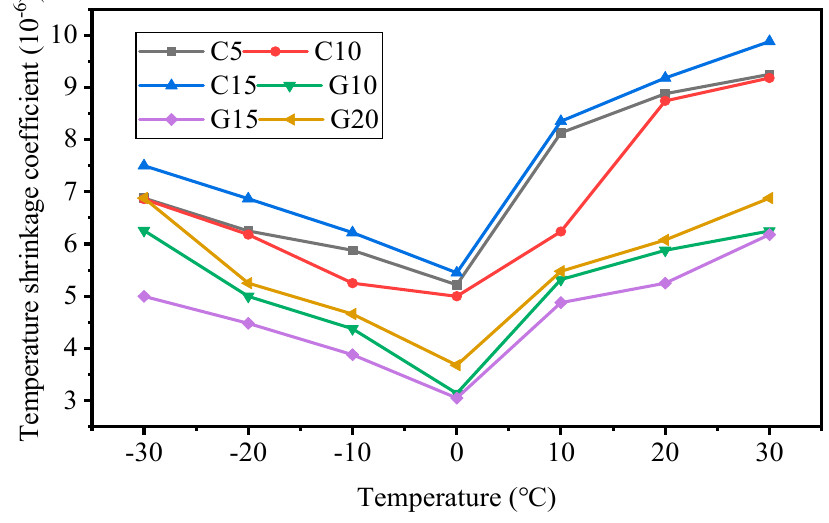
Figure 9. Variation of temperature shrinkage coefficient of typical sample with temperature.